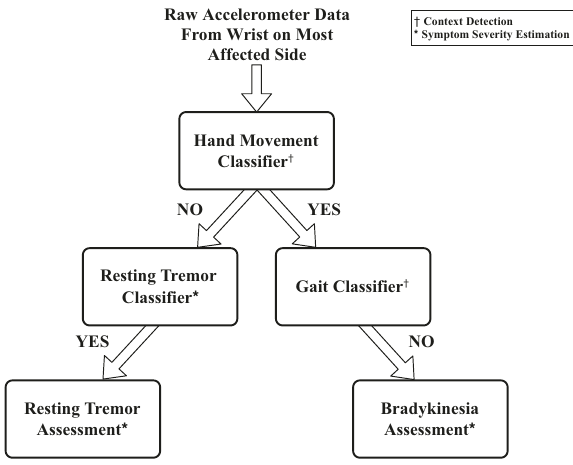
Fig. 1 Flow chart illustrating the hierarchical approach for detection and assessment of resting tremor and hand bradykinesia using accelerometer data from a wrist-worn device. This approach utilizes context detection (hand movement and gait) to identify periods of interest from raw sensor data and subsequently performs detection and assessment of motor symptoms (tremor and bradyki- nesia). Tremor is assessed when the hand is at rest and bradykinesia is assessed during periods of hand movement that are not due to